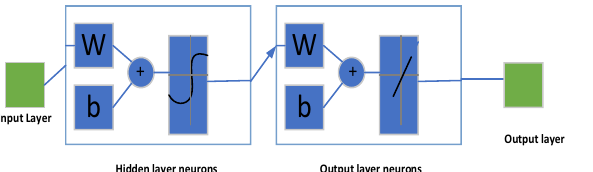
Figure 9. Block diagram of neural network.